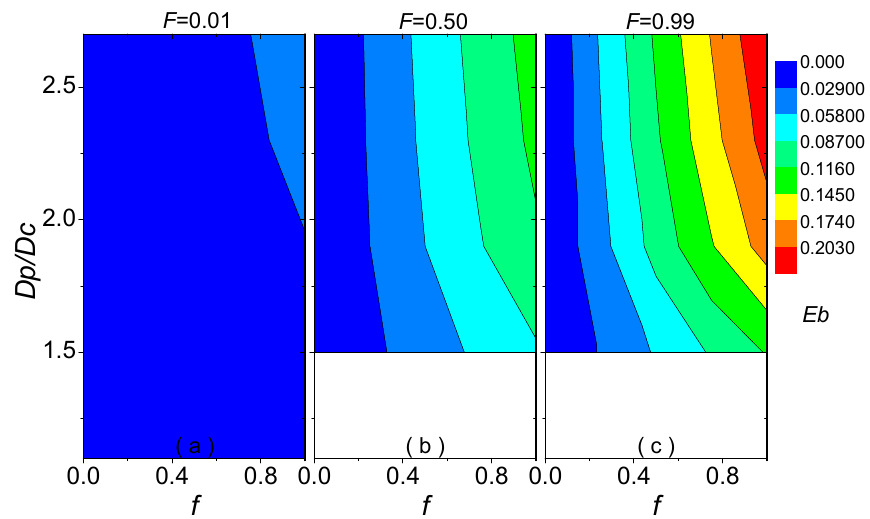
Figure 4. Absorption enhancement of BC reduced by the blocking effect of absorbing coating ( E b ) as functions of coating absorbing volume fraction ( f ) and shell/core ratio ( Dp / Dc ). Coated volume fractions of BC with values of 0.01, 0.50, and 0.99 are shown from left to right. A BC fractal dimension of 2.8 and log-normal size distribution with r g of 0.075 µ m and σ g of 1.59 are considered.